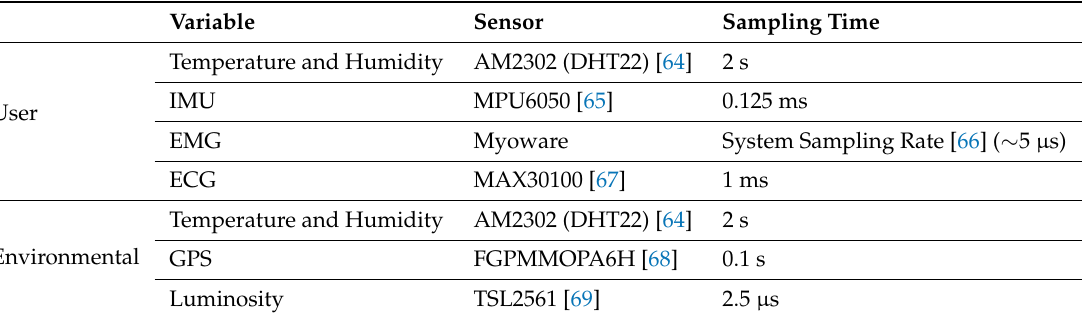
Table 1. Sampling time ratio for each